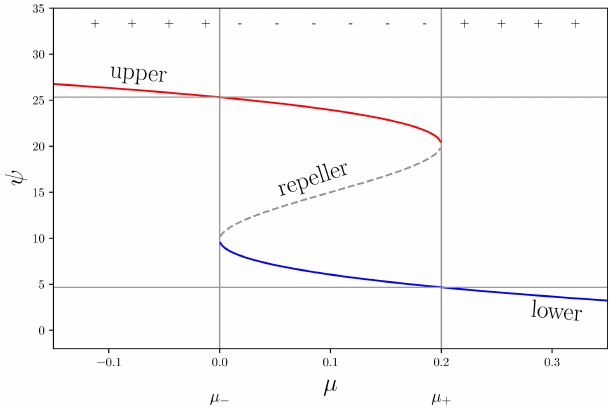
Figure 1. Example bifurcation diagram of the AMOC ( (cid:57) ) in re- sponse to a control variable µ . The red branch is the on state (up- per), and blue is the off state (lower). The upper branch deforms when closer to the bifurcation points that are connected though the repeller (dashed line). The two bifurcations points are indicated as µ + (collapse point) and µ − (resurgence point). The top ± symbols indicate a unimodal ( + ) or bimodal ( − ) regime.